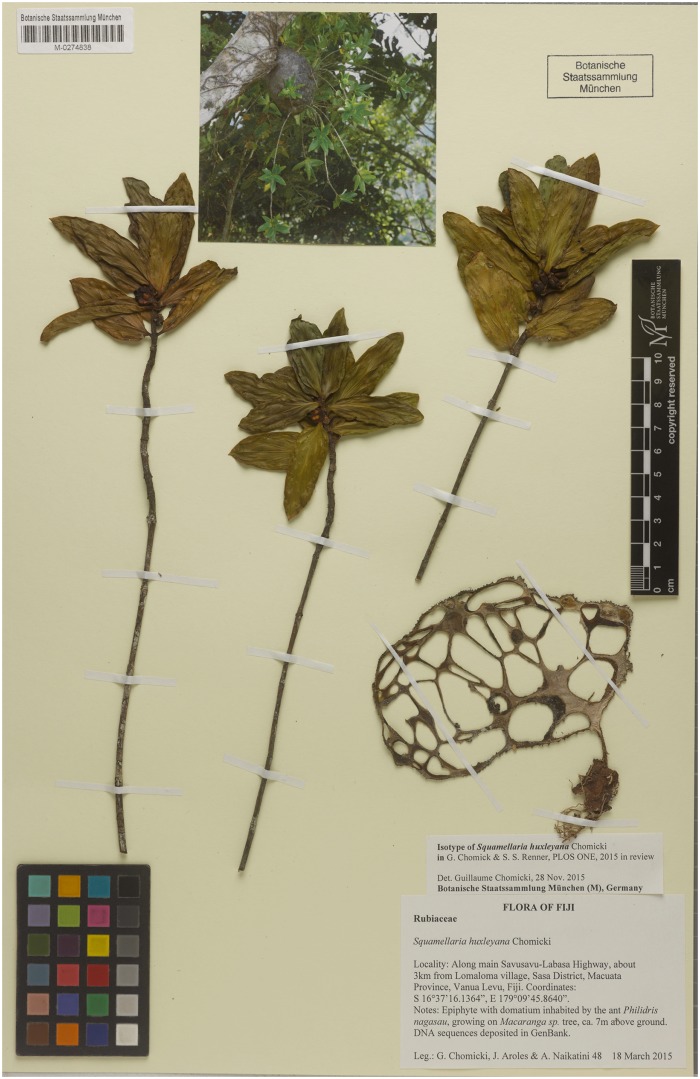
Isotype of Squamellaria huxleyana, G. Chomicki, J. Aroles, N. Naikatini 48 (M, barcode: M-0274838).